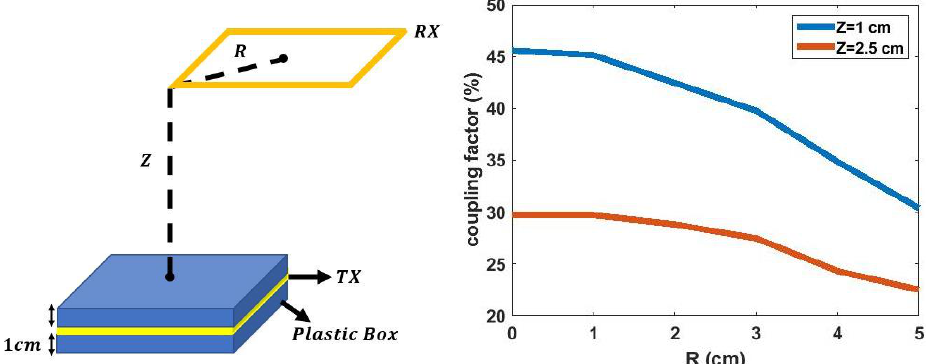
Figure 9. Measured coupling factor vs. alignment.